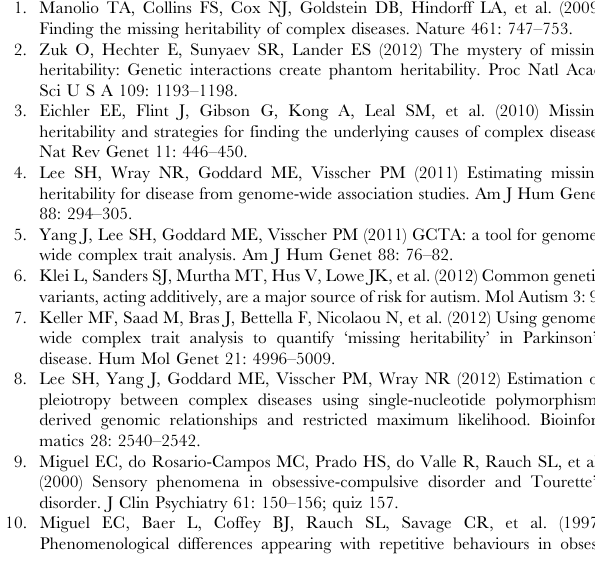
Table S9 Partitioning analysis of heritability based on brain and skeletal muscle eQTL annotations. Partitions include eQTLs identified in brain only, in muscle only, in both brain and muscle, and non-eQTL SNPs. Table S10 Proportion heritability and correlation with chromo- some length for all phenotypes analyzed with GCTA. Table includes data from representative account of GCTA publications with respective reference, phenotype studied, proportion of total twin/family study heritability estimated by GCTA analysis, correlations reported for heritability by chromosome and chro- mosome length, adjusted correlation reported for heritability by chromosome and chromosome length (upon removal of